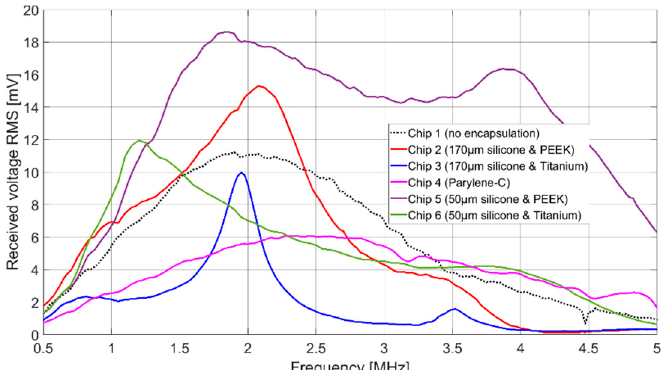
Figure 11. Receiving spectrum in Fluorinert with and without housing, 60 V DC , 10 V AC , sinusoidal burst count 20, distance 83 mm. Table 2. Results from the transmit experiments in Fluorinert for different encapsulations60 V DC , 10 V AC , burst count 20, distance 83 mm.